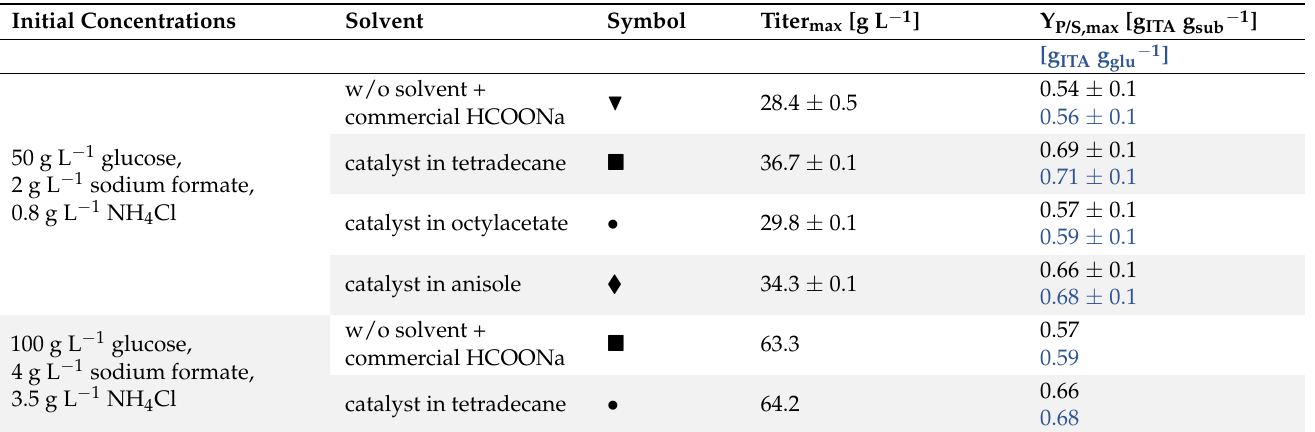
Table 6. Itaconate production with formate solutions from CO 2 -hydrogenation experiments.